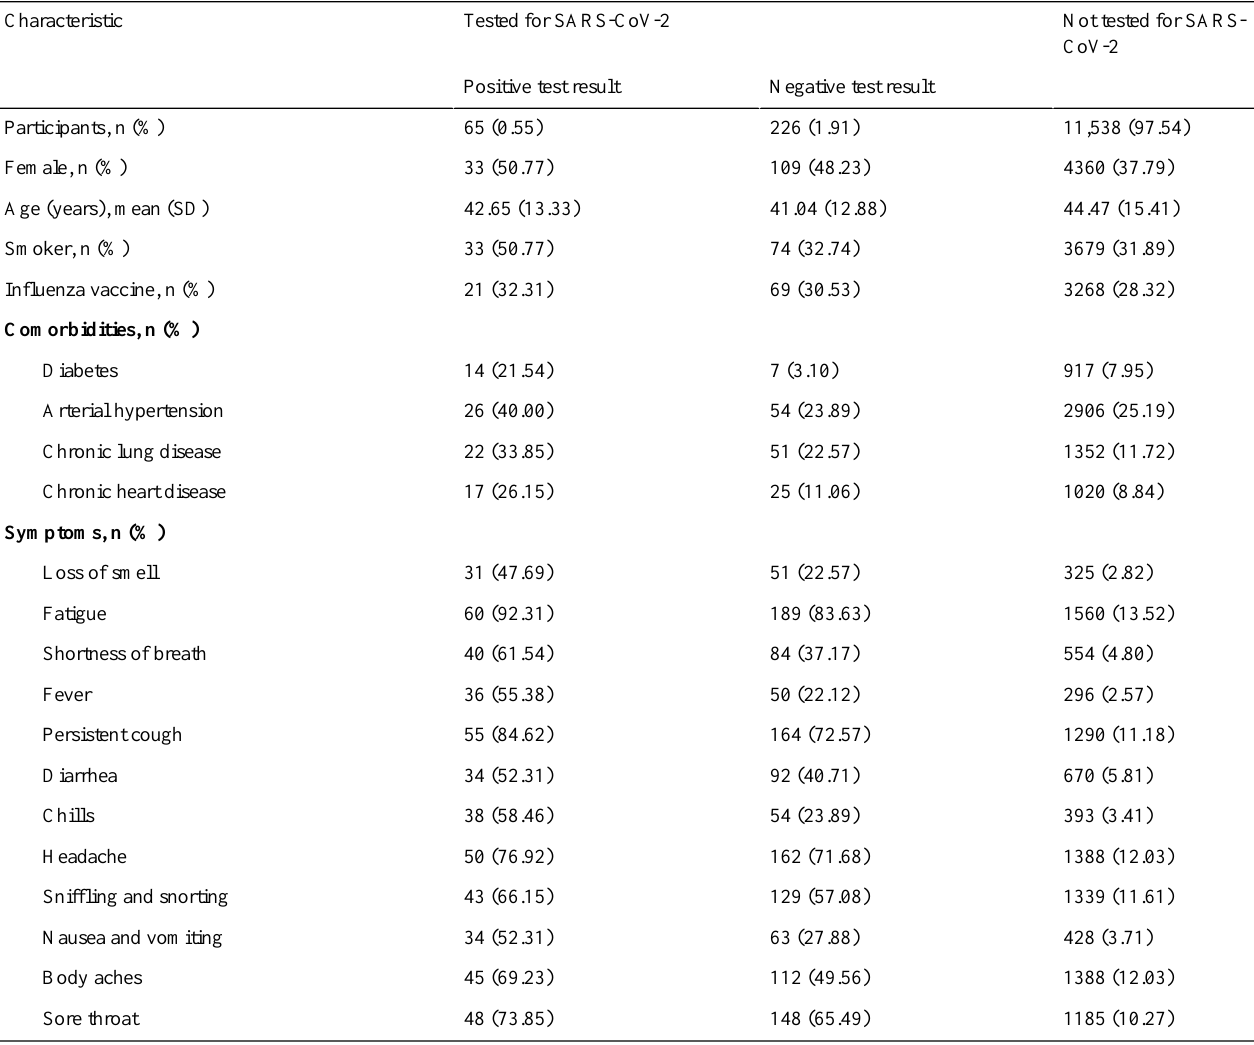
Table 1. Characteristics of participants (N=11,829).